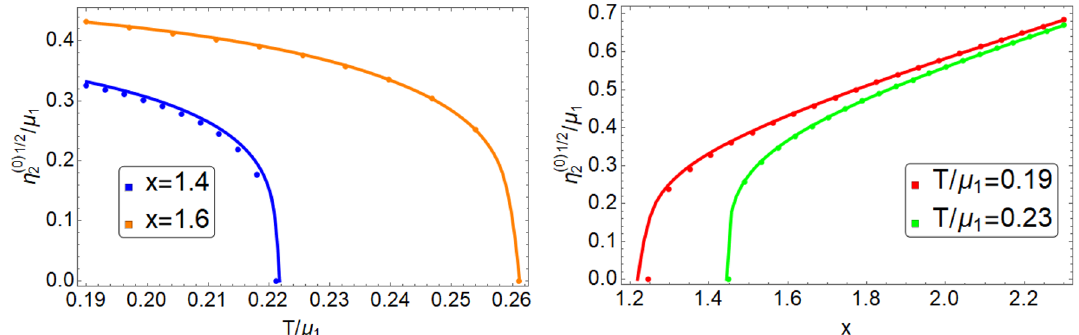
Figure 12 . The uniform SC order parameter η (0) as the function of temperature T (left) and doping 2 parameter x(right). The solid curves in color stand for η (0) in SSC phase, while the dotted curves 2 in color stand for η (0) in the absence of CDW. 2